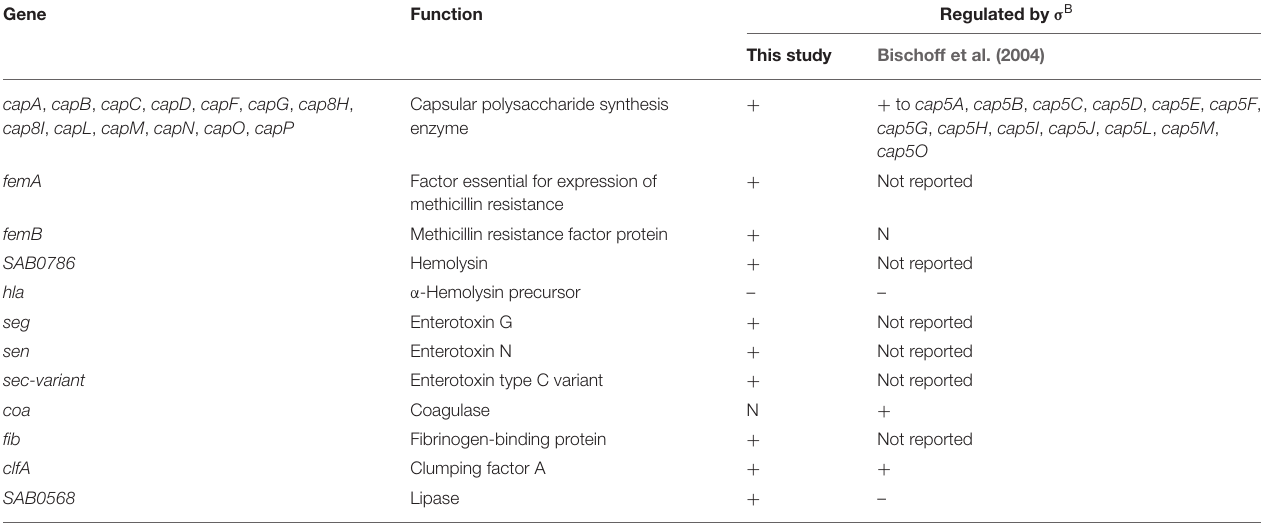
TABLE 4 | List of virulence genes affected by σ B in this study in comparison to Bischoff et al. (2004).